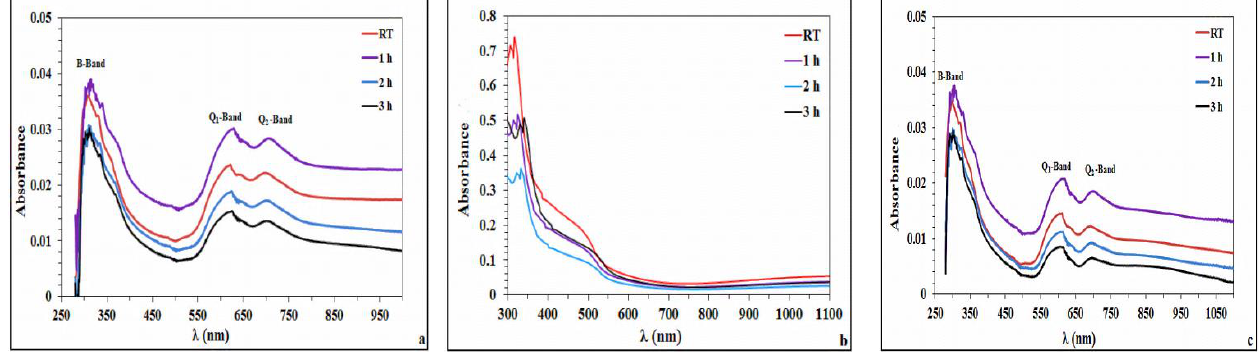
Fig.1: The variation of (αhγ) 2 versus the photon energy (hγ) for as-deposited and annealed a: ZnPc, b: CdS and c: ZnPc/CdS blend films at different annealing